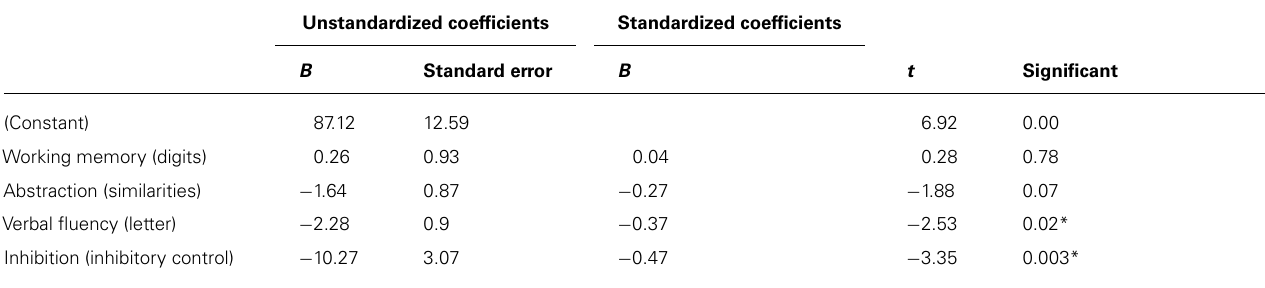
Table 4 | Multiple linear regression model for reappraisal